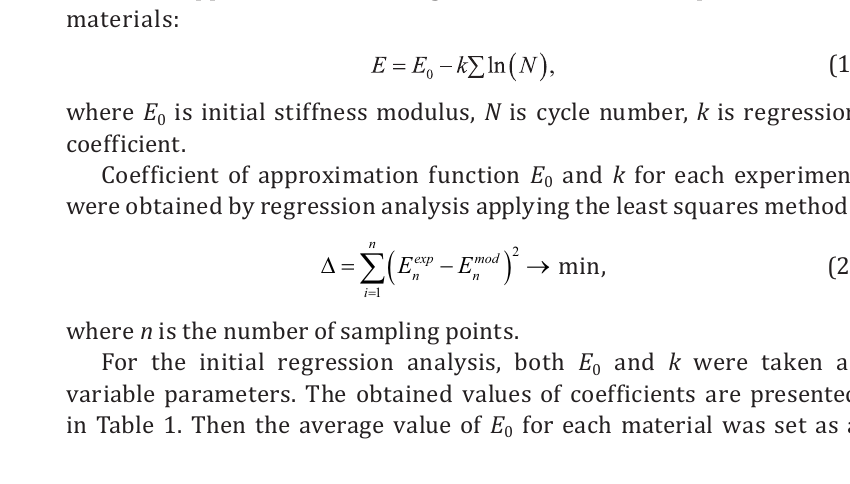
Table 1. Results of the initial regression analysis SMA11